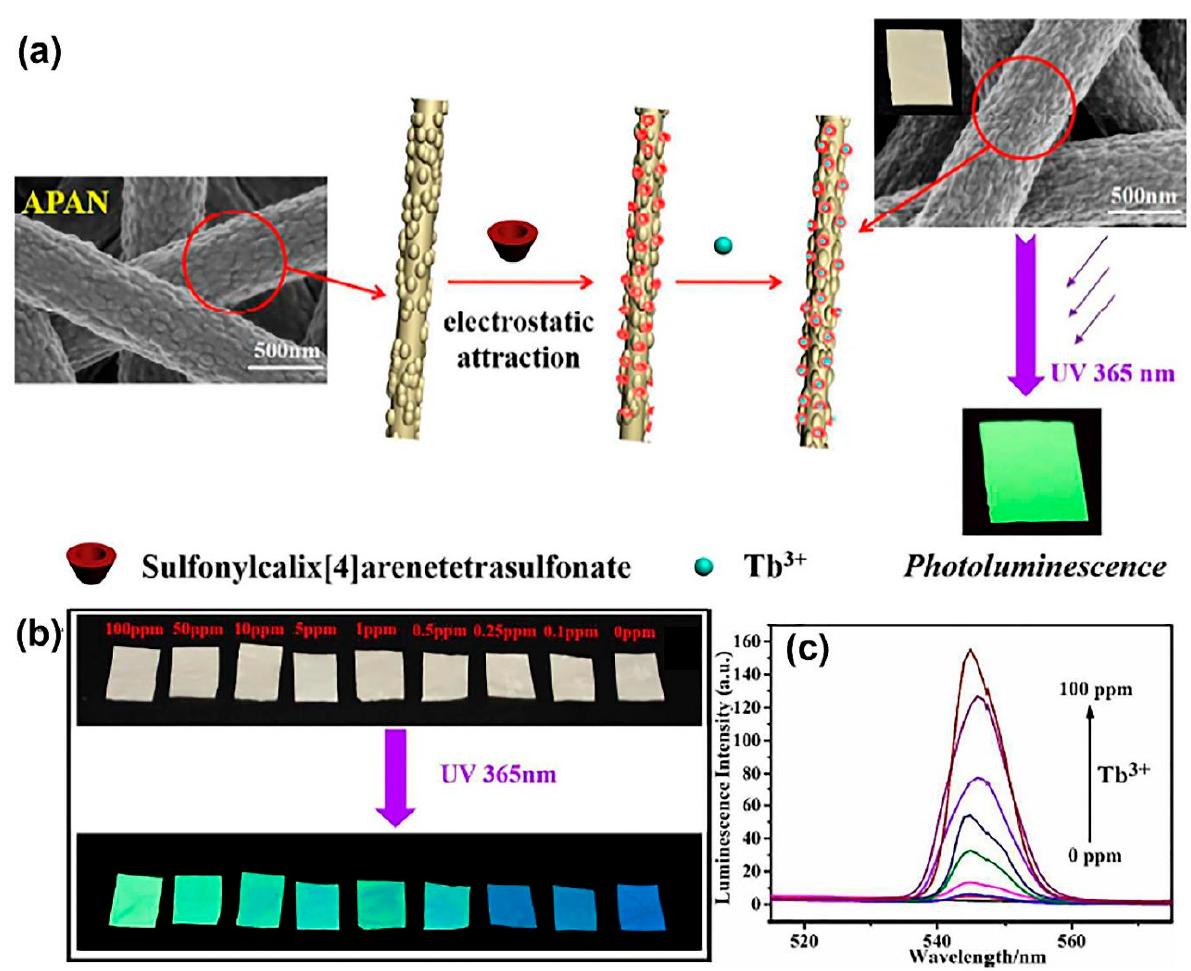
Figure 5. Electrospun-NFs-based chemosensors for water pollutant. ( a ) Preparation procedure and photoluminescent behavior of sulfonylcalix[4]arene-functionalized APAN nanofibrous for the adsorptive removal Tb 3+ ions. ( b ) Photographs of NFs after immersing into Tb 3+ aqueous solutions (0–100 ppm). ( c ) Fluorescence spectra of NFs (reproduced with permission from [173], copyright © 2018, Royal Society of Chemistry).